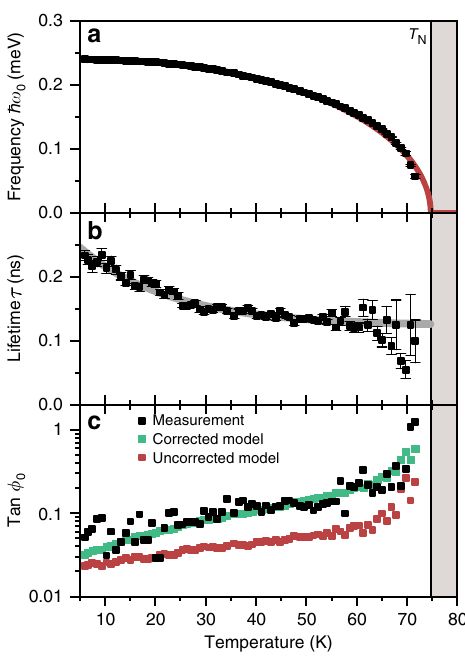
Fig. 4 Temperature-dependent Z -mode characterisation in YMnO 3 . a Frequency, b relaxation time, and c tangent of the initial phase of the optically induced spin precession as function of temperature. Green and red: model calculations with and without correction for non-damping-based excitation mechanisms, respectively. Grey line: fi tted exponential